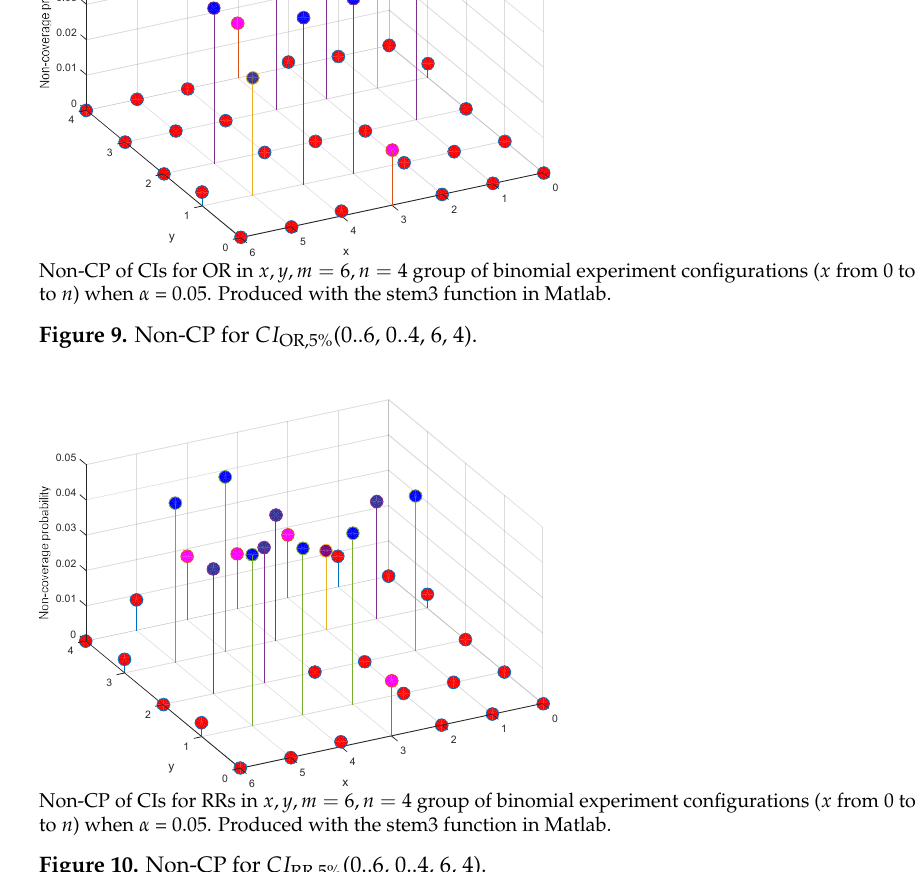
Figure 10. Non-CP for CI RR,5% (0..6, 0..4, 6,